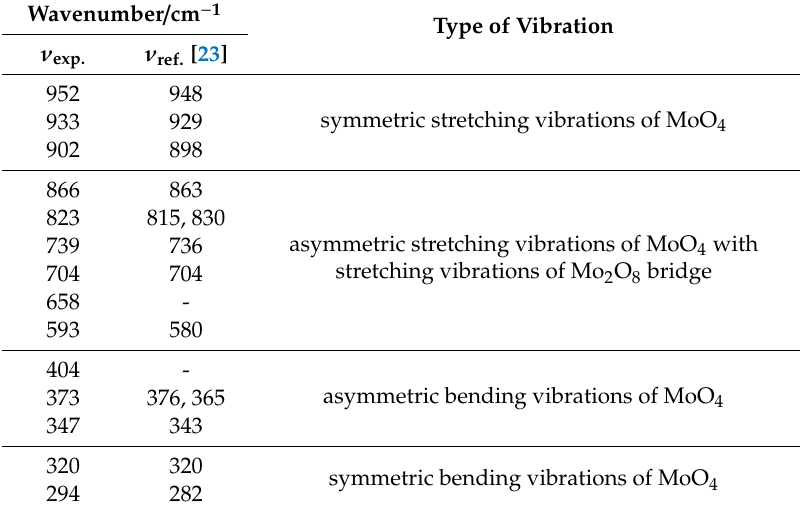
Figure 2. ( a ) Temperature-dependent Raman spectra of polycrystalline KBi(MoO 4 ) 2 from room temperature to 1023 K; ( b ) deconvolution of Raman spectra by Gaussian (1023 K) and Lorentz (from RT to 923 K) function as a function of temperature. Table 2. The assignment of major vibrational modes of crystalline KBi(MoO 4 ) 2